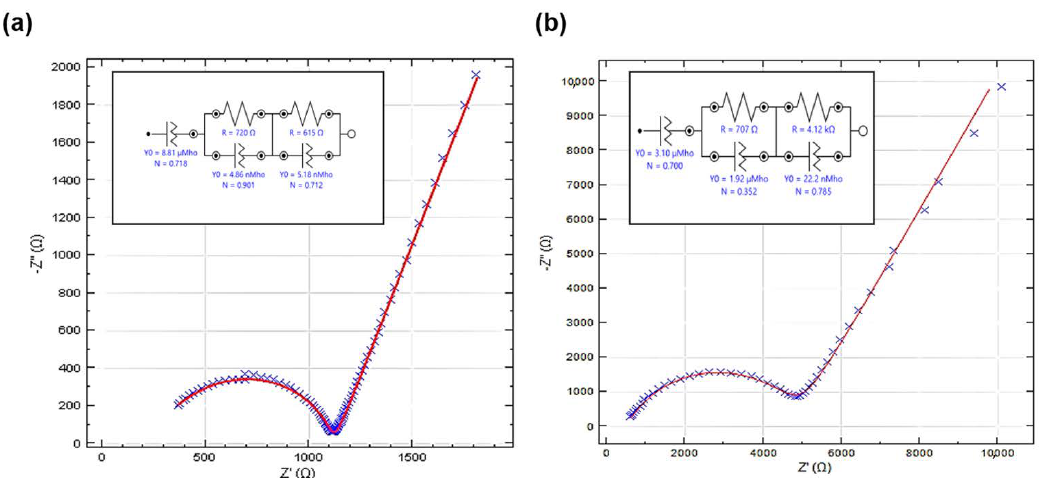
Figure 5. A typical recorded Nyquist plot for CA-assisted ( a ) and EDTA-assisted ( b ) compounds along with the simulated curve using the presented equivalent circuit.